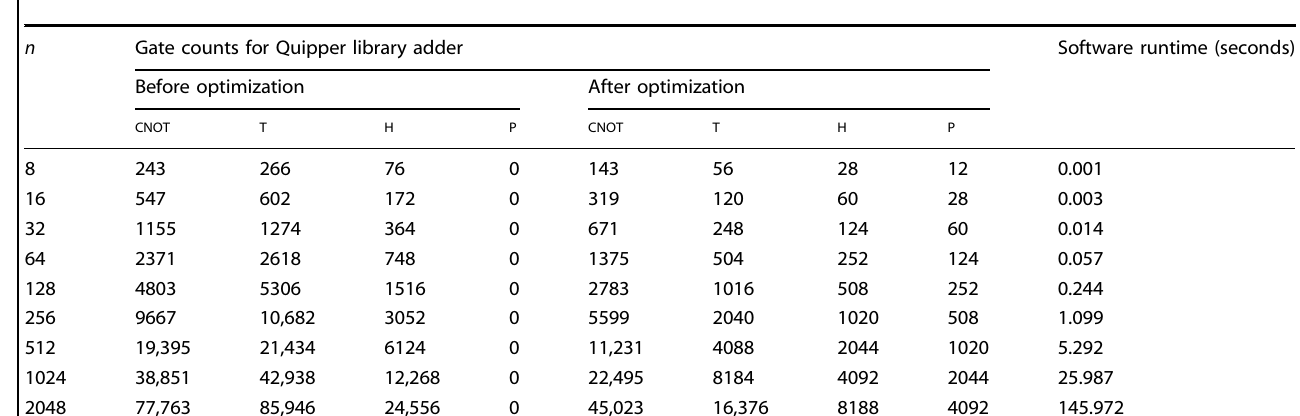
Table 1. Light optimization of adder circuits: QFA (top) and Quipper library (bottom) n Gate counts for approximate